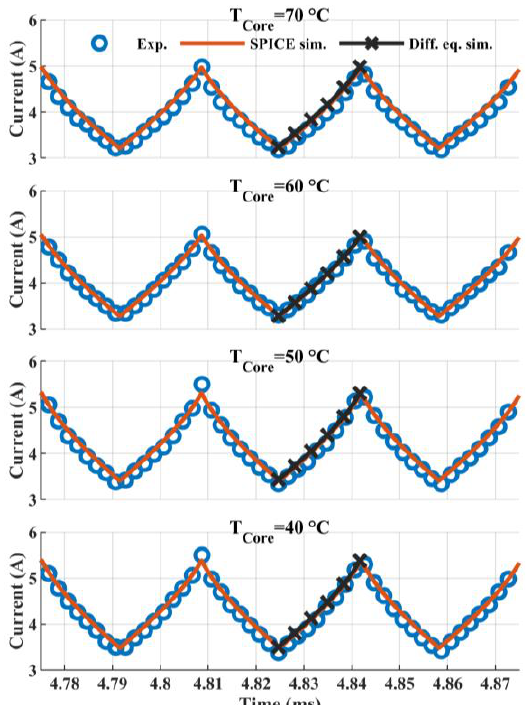
Figure 10. Comparison of the experimental current waveform with the simulation results from SPICE and the differential equation for a duty cycle of 51% at different temperatures.